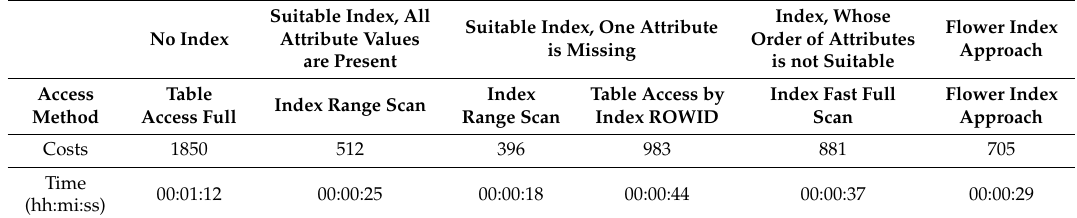
Table 1. Index processing—costs and time demand.